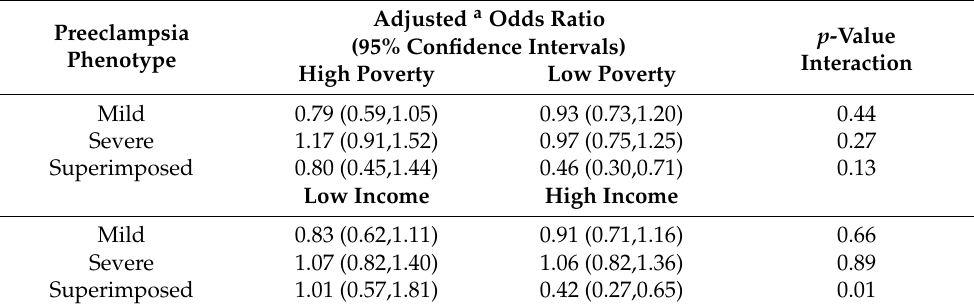
Table 4. Associations between greenspace (average NDVI) within 500 m buffer surrounding partici- pant residence (>75% vs. ≤ 25%) by neighborhood SES factors, 2000–2006.